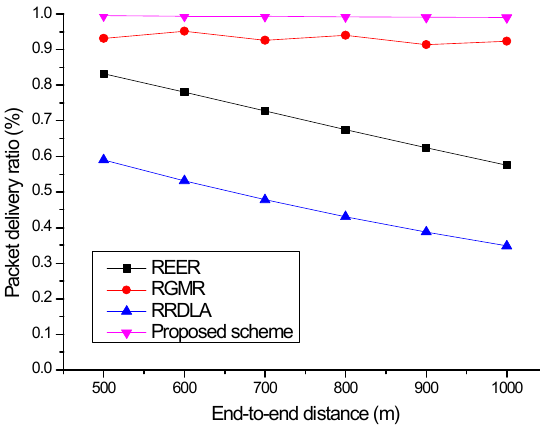
Figure 6. Packet delivery ratio vs. end-to-end distance with 90% of link